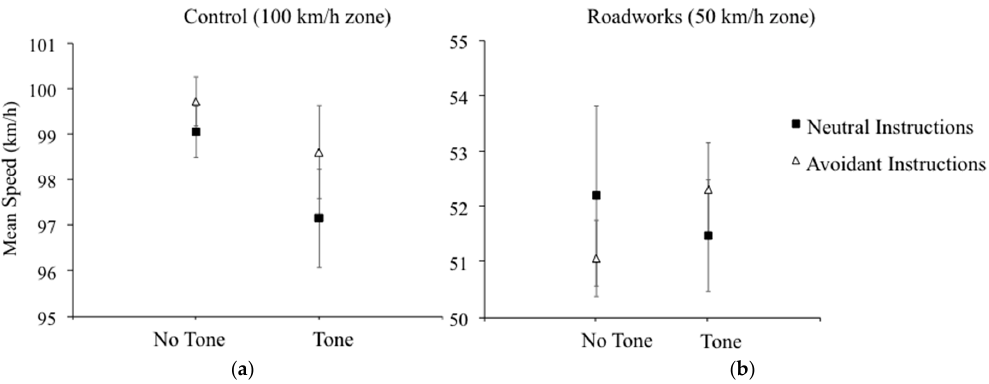
Figure 4. Mean speed in control ( a ) and roadworks ( b ) conditions in the neutral and avoidant instructions condition, with and without secondary task (tone counting).